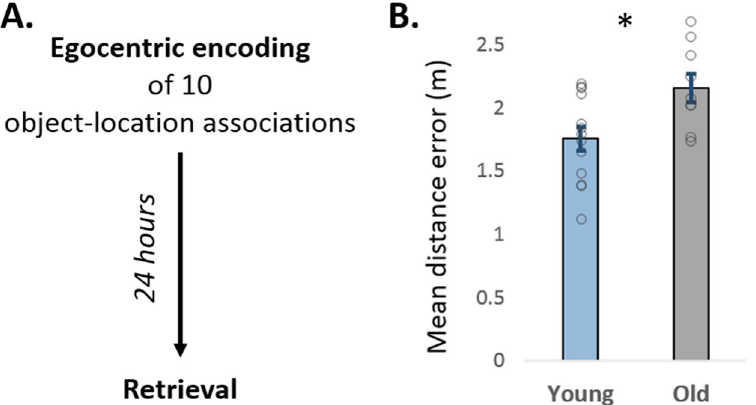
Figure 5. Overnight retention of navigational memories after egocentric encoding. ( A ) The procedure of experiment 2. Retrieval accuracy was assessed 24 hours after encoding in the egocentric condition. ( B ) Older adults showed larger distance errors, indicating inferior overnight retention of navigational memories. Data are presented as mean ±